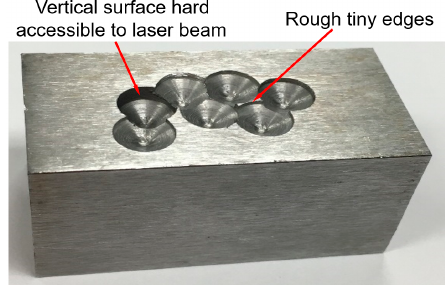
Figure 4. An H13 tool steel substrate with ball-indented defects.